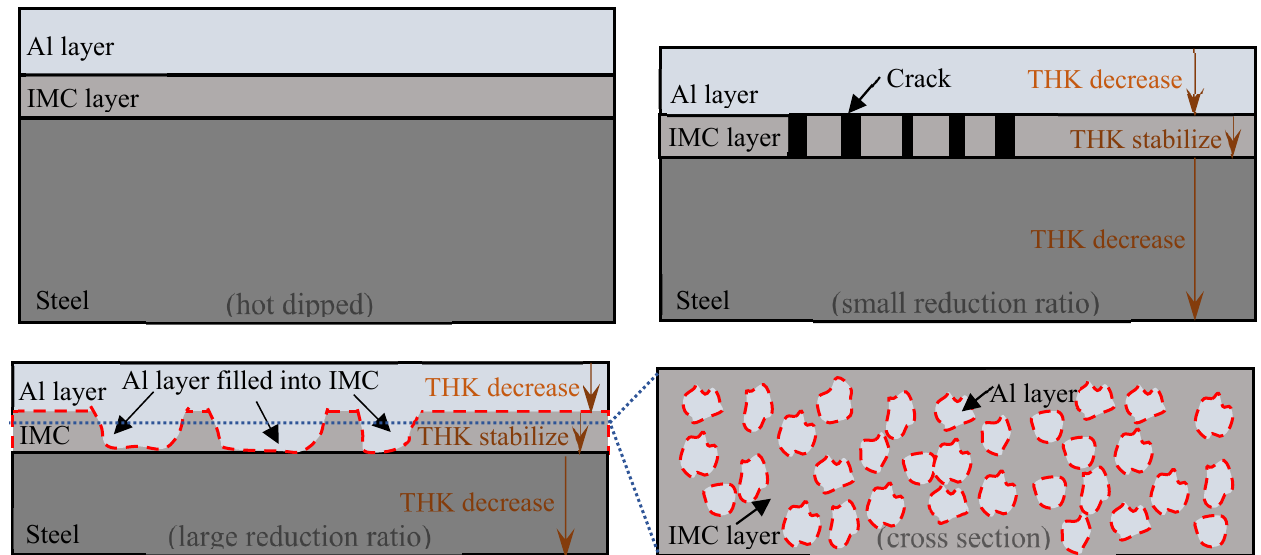
Figure 7. Deformation of Al-Si coating during cold rolling. The adhesive force tests and results of AS60/60 coatings are illustrated in Figures 8 and 9a, respectively. The failure type was adhesive failure (AF) for the cold-rolled coatings at different reduction ratios. Namely, visible failure occurred at the interface between the adhesive agent and the adhered substance, and the coatings were not destroyed. It was indicated the adhesion force between the adhesive agent and the coating was smaller than the cohesion force of the coating or the cohesion force of the adhesive agent.